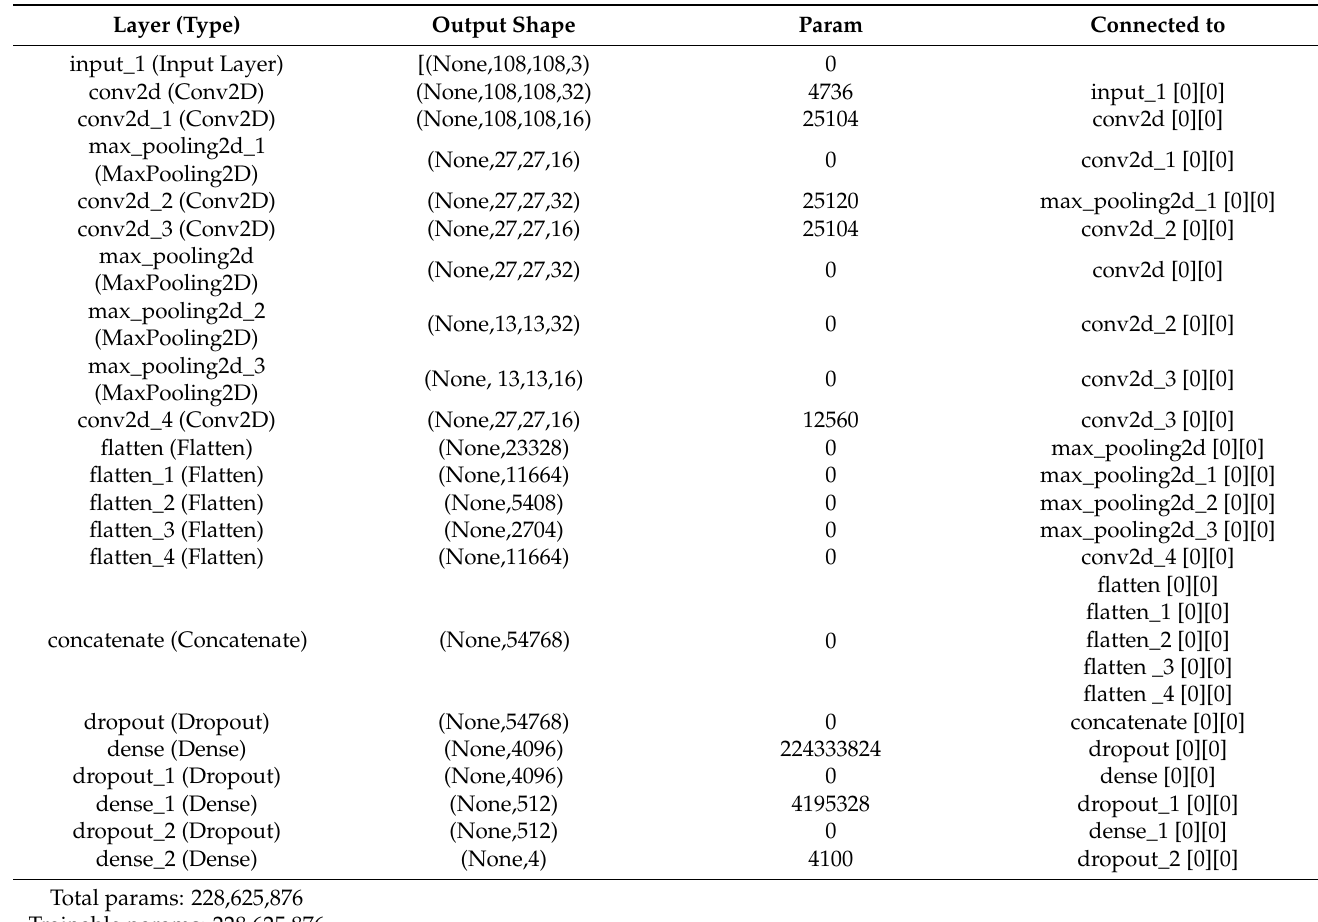
Table A2. Details of the proposed DS-SoybeanNet with 7 × 7